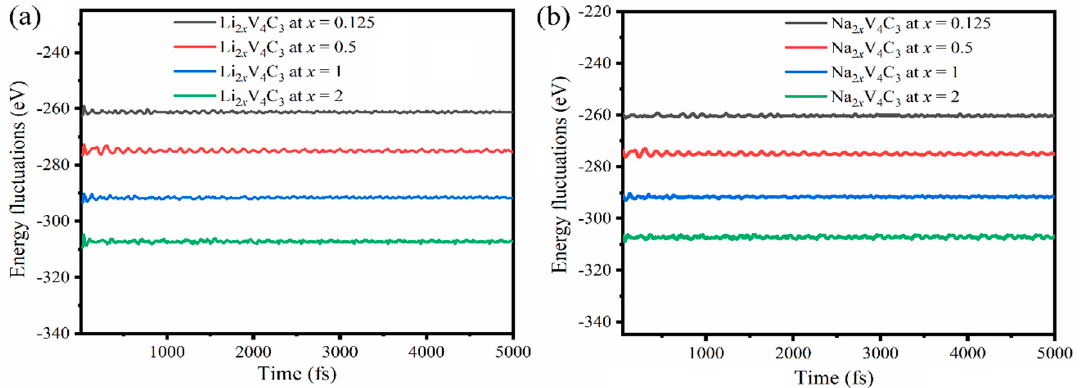
Figure 3. Energy fluctuations vs. time duration for ( a ) Li 2 x V 4 C 3 and ( b ) Na 2 x V 4 C 3 at x = 0.125, 0.5, 1, and 2.